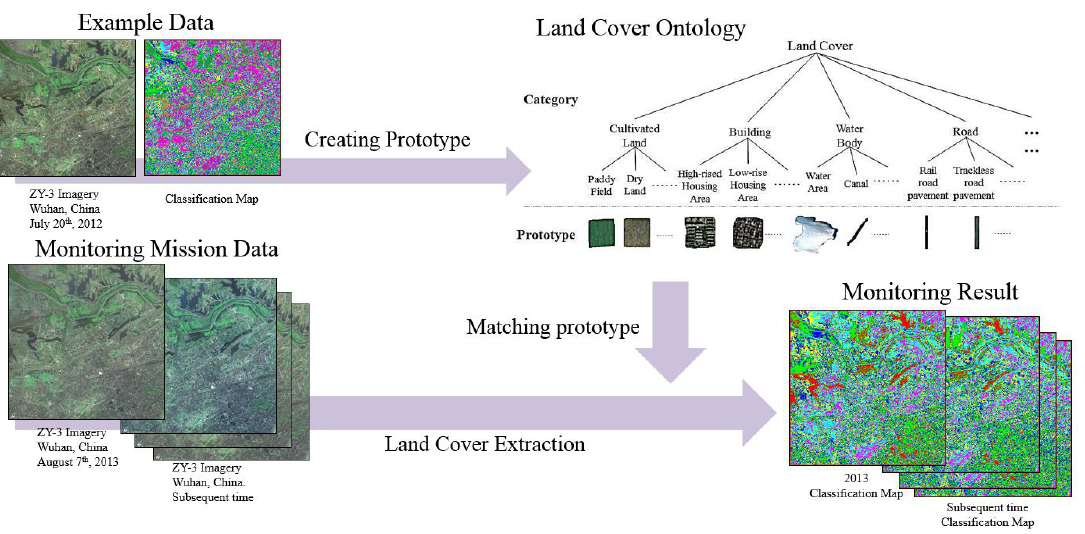
Table 1. Accuracy assessment of land cover extraction.